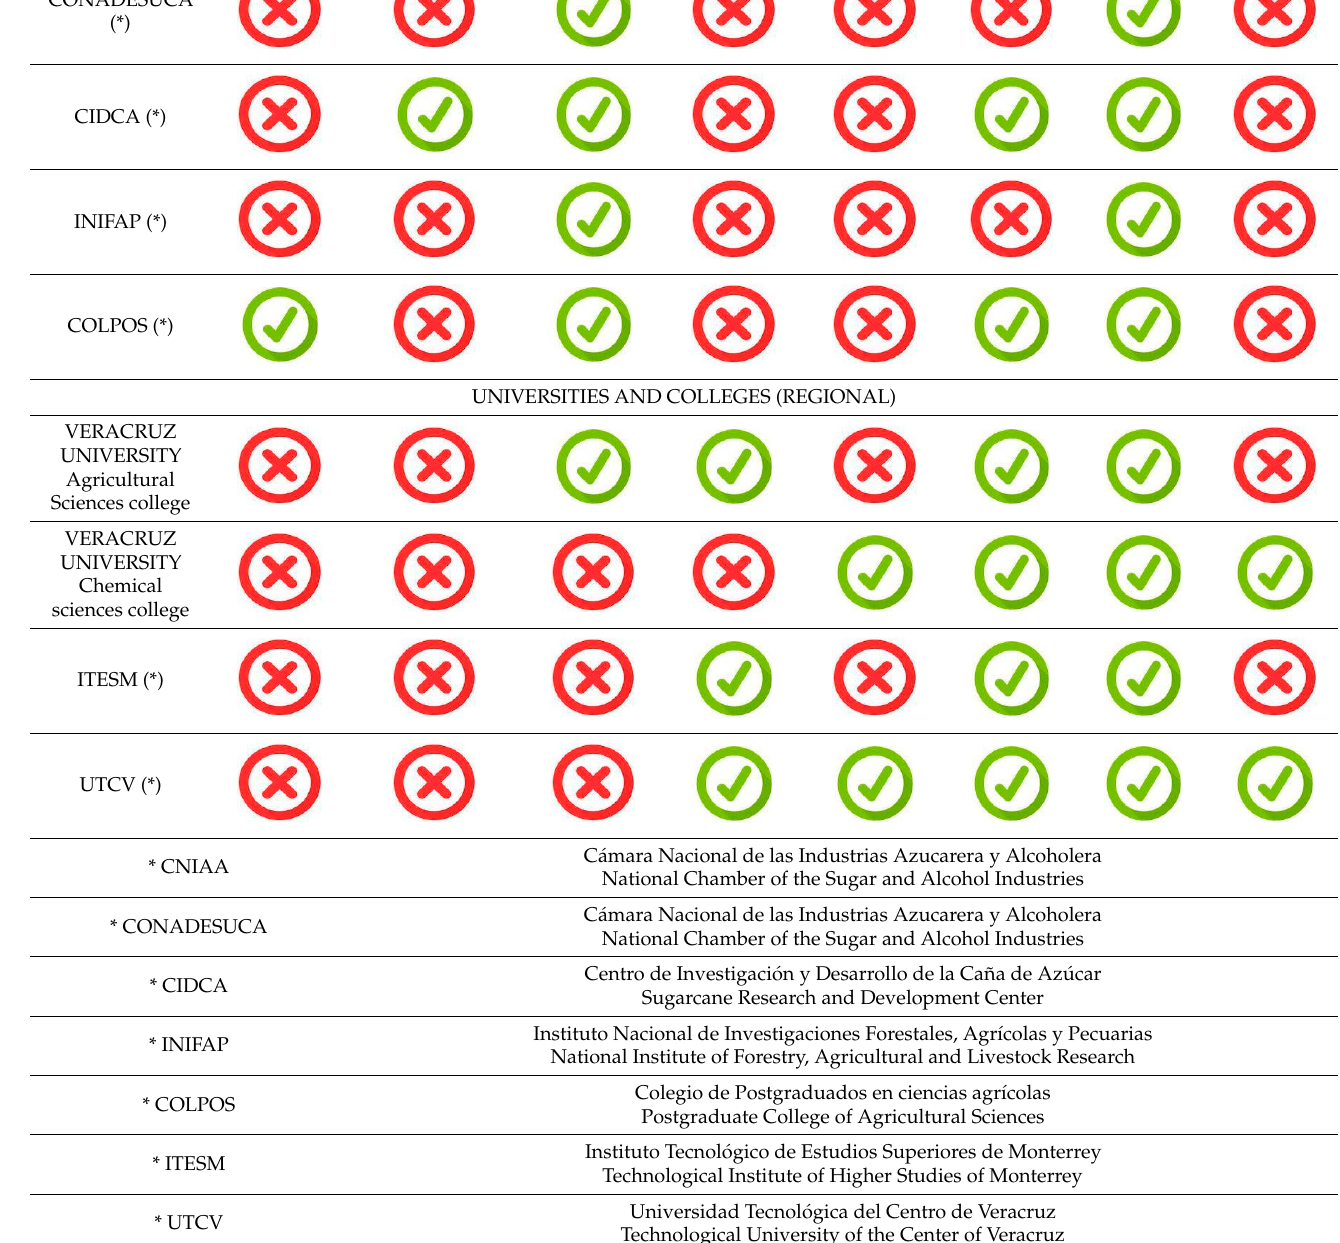
Table 3. Relations of R&D system with the conservative, intermediate and innovative network actors.